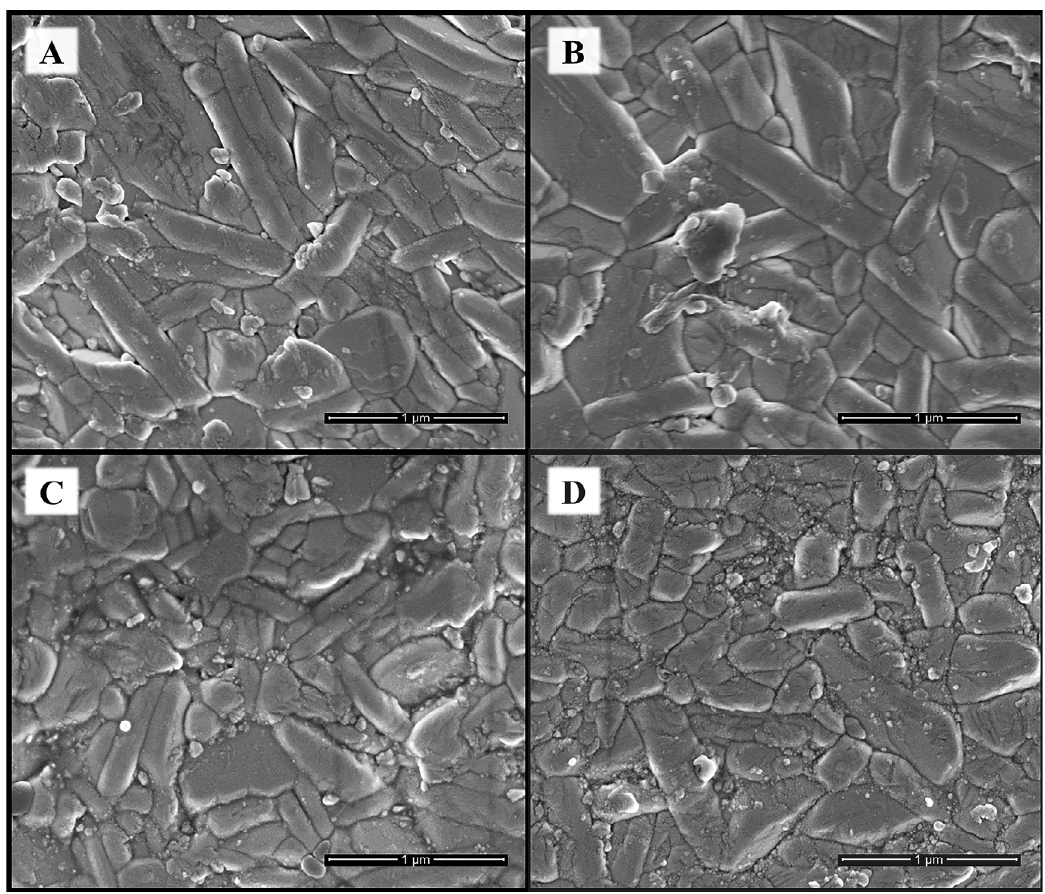
Ti O powders: A) 4 3 12